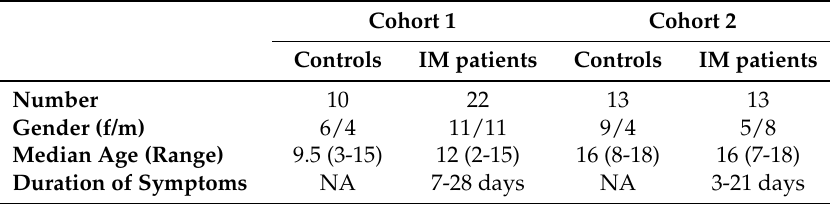
Table 1. Demographical characteristics of patients and control subjects.